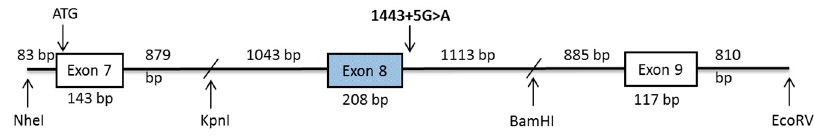
Figure 1. Schematic diagram of the DHP minigene construct containing exon 7, part of intron 7, exon 8, part of intron 8, exon 9 and part of intron 9.